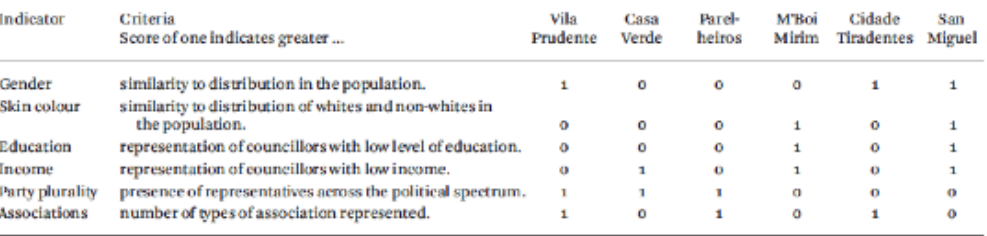
Tab. 1 – Types of inclusion in six LHCs located in areas with different histories of